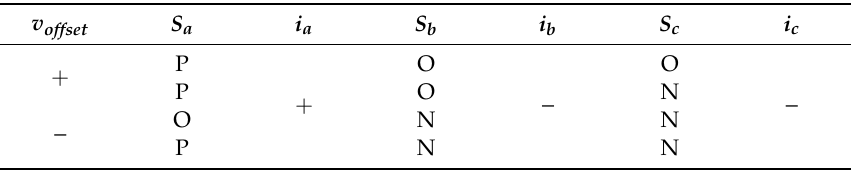
Table 2. States after the o ff set voltage is injected, the sign of the injected o ff set voltage, and the sign of input currents in a case of sector